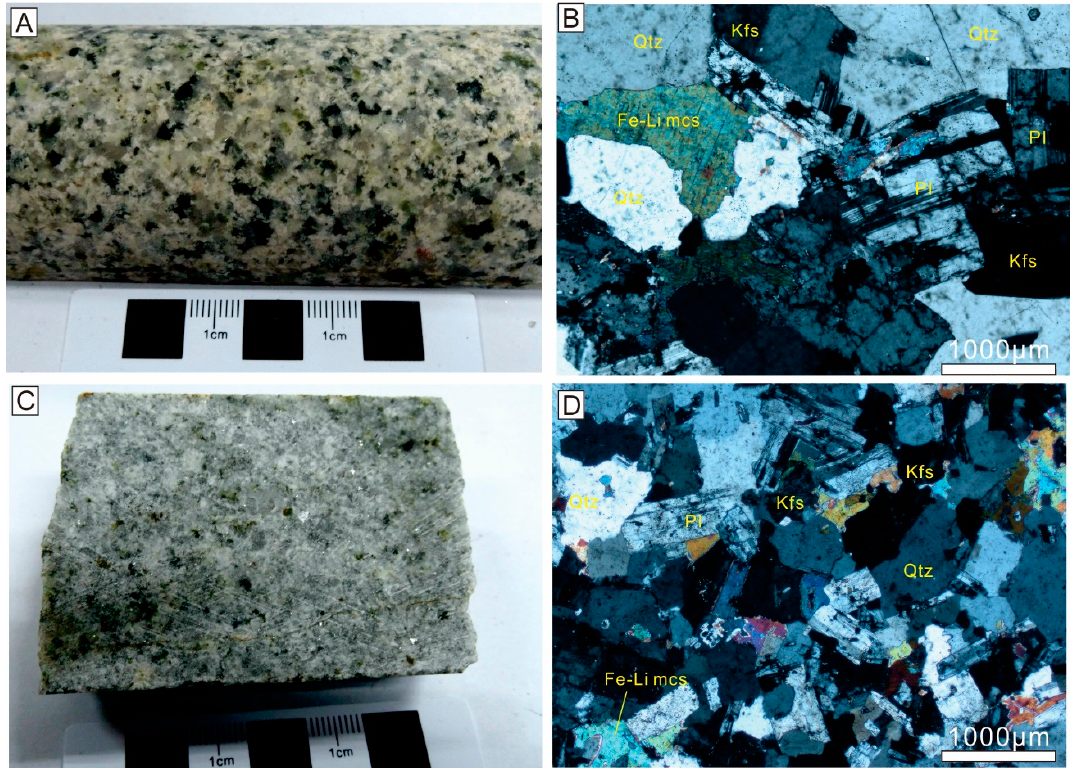
Figure 4. Photographs of granite samples from the Maoping W–Sn deposit. A and B ,